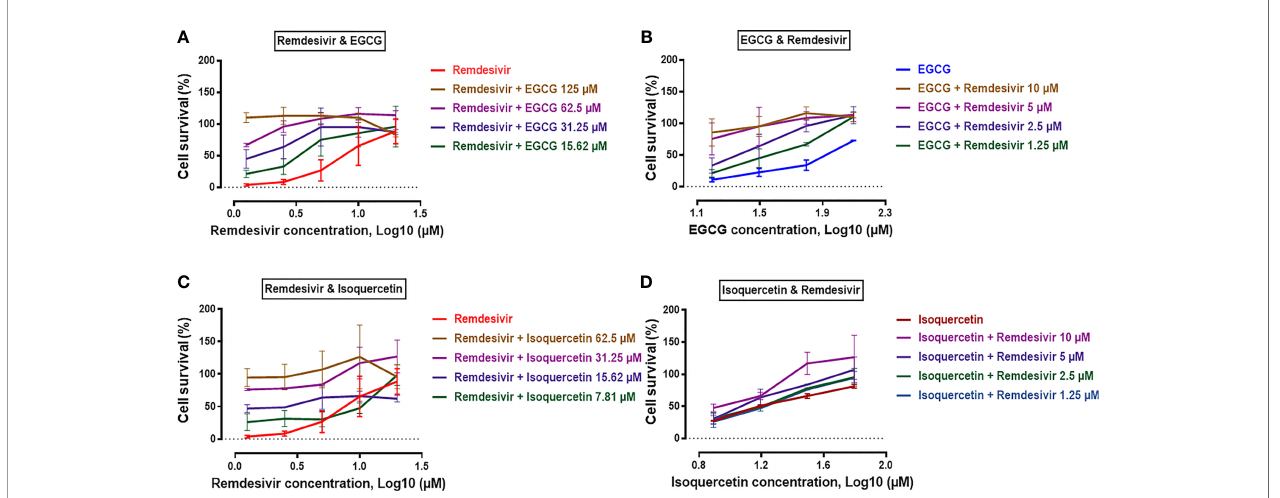
FIGURE 1 | Dose-response curves of antivirals compounds tested alone or in combination against SARS-CoV-2. Serial dilutions of Remdesivir (1.25-20 m M) combined with constant concentrations of EGCG (A) or Isoquercetin (B) . (C) Serial dilutions of EGCG (15.62-125 m M) combined with constant concentrations of Remdesivir. (D) Serial dilutions of Isoquercetin (7.81-62.5 m M) combined with constant concentrations of Remdesivir. X axis: Compound concentration in Log10 ( m M). Y axis: Percentage of cell survival. Three different experiments were done in quadruplicates each time for both drug